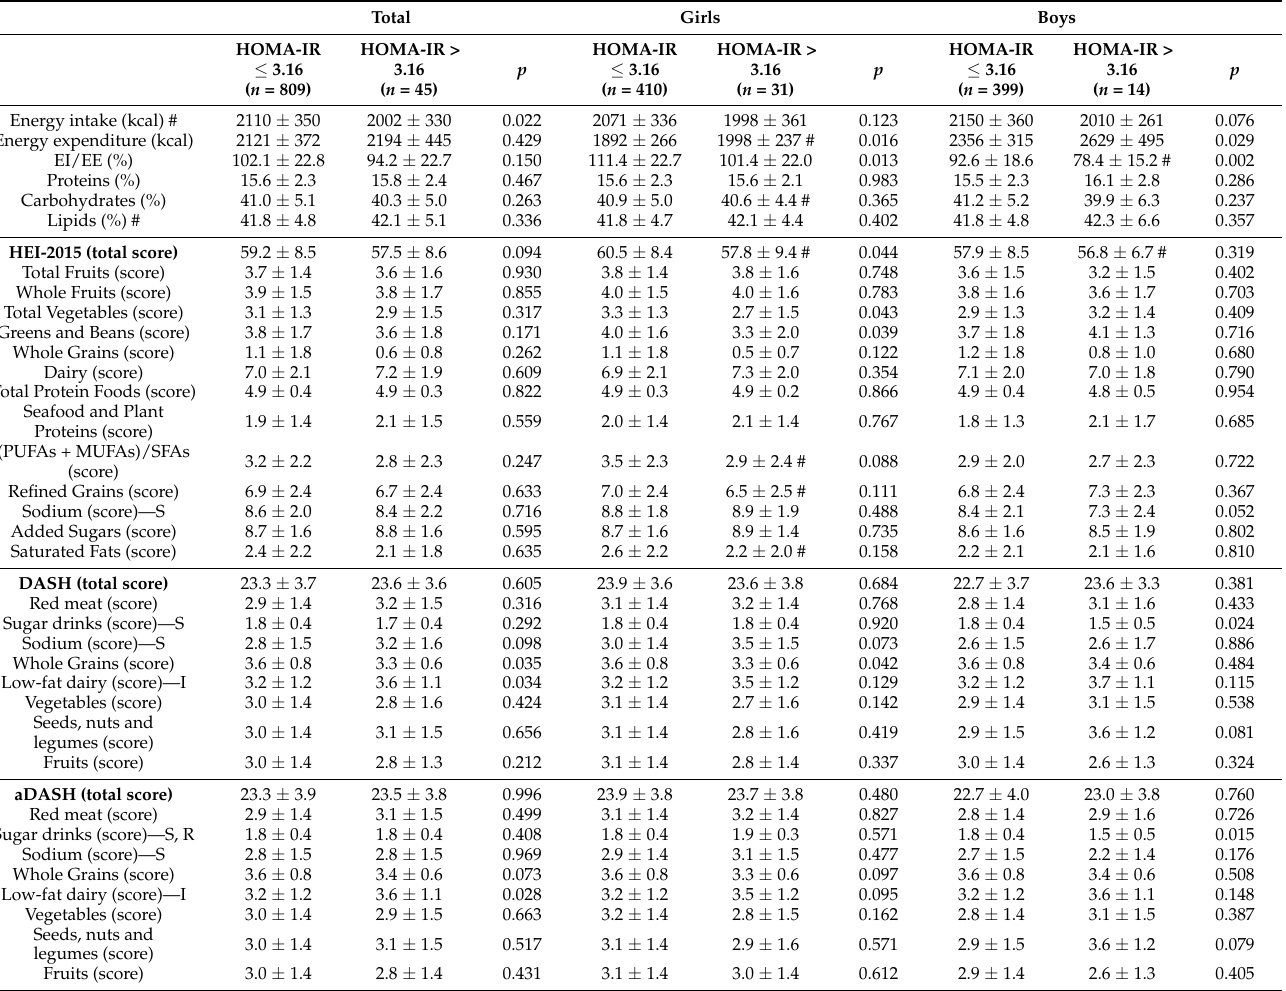
Table 3. Diet quality in the schoolchildren studied according to HOMA-IR and